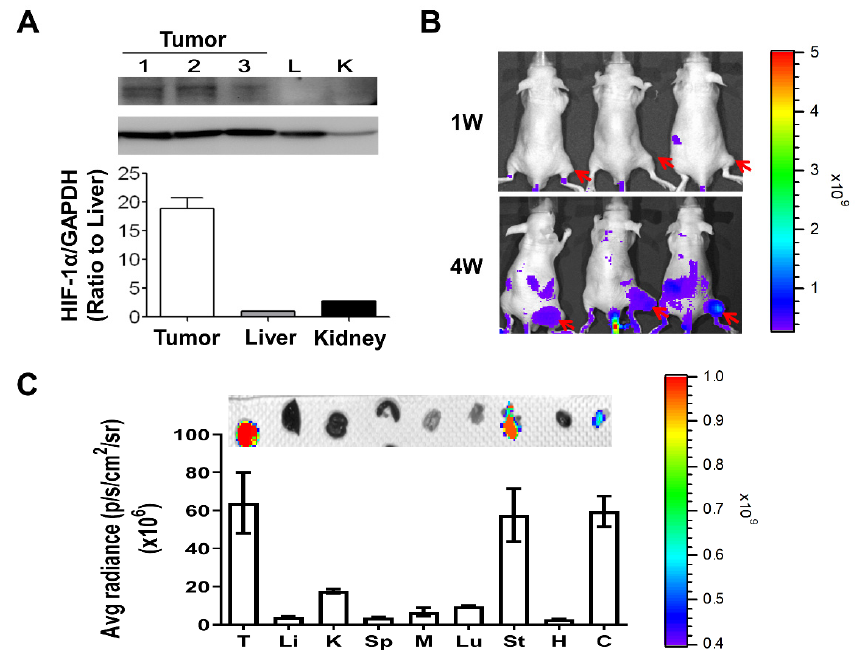
Figure 4. Tumor hypoxia detection. Two hypoxia markers, namely HIF-1 α and carbonic